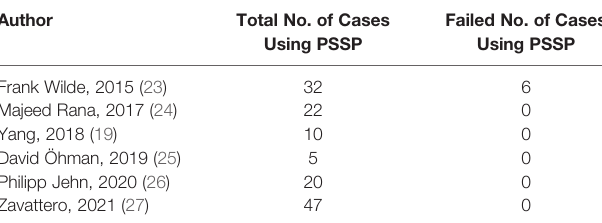
TABLE 1 | Literature review on studies using PSSP in maxillofacial reconstruction.